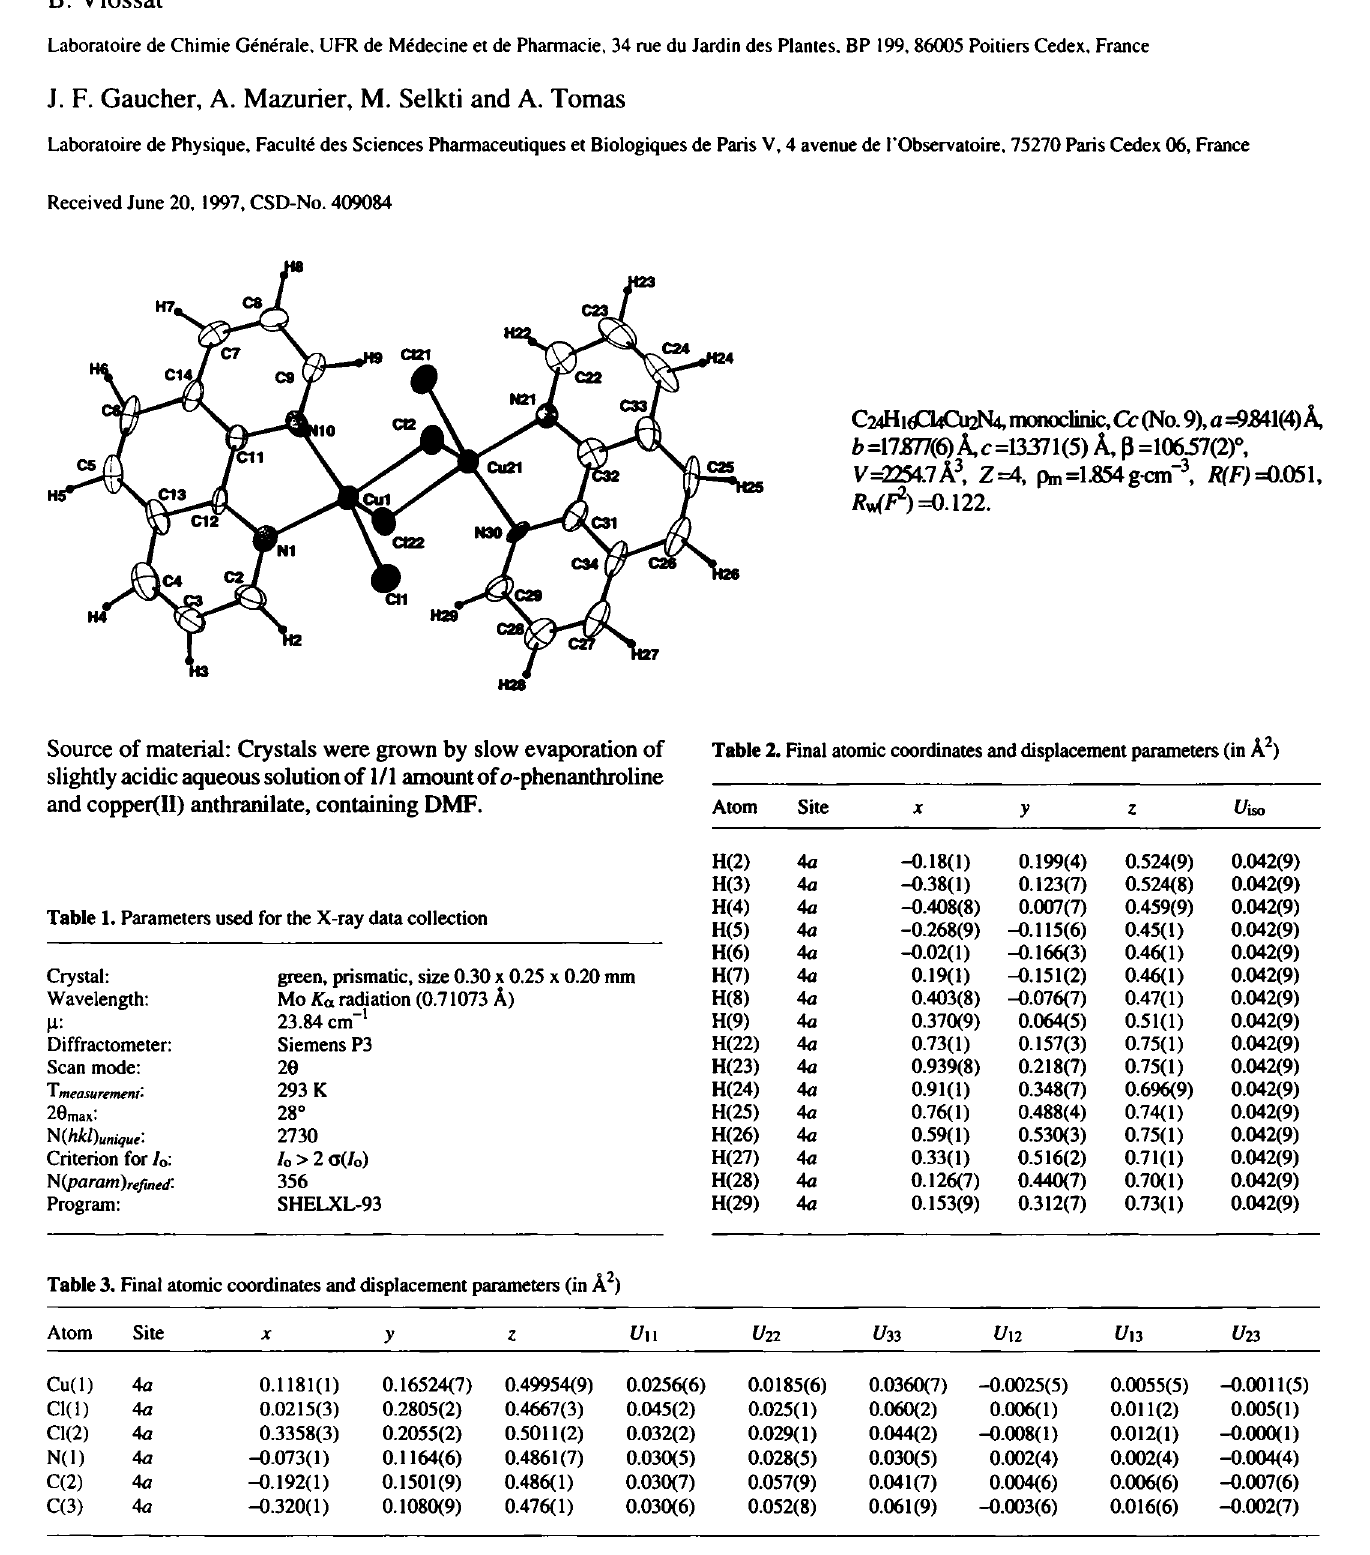
Table 3. Final atomic coordinates and displacement parameters (in